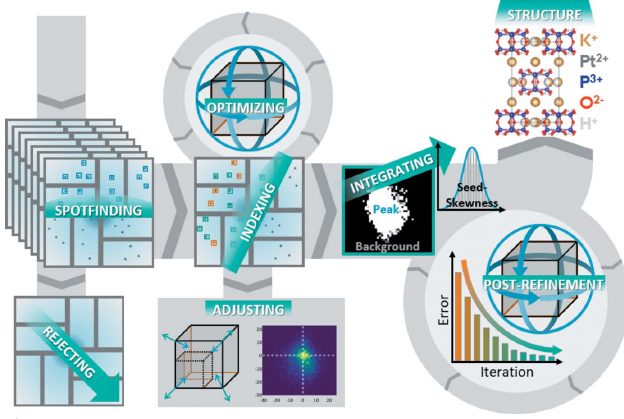
Figure 2 Schematic of the SFX data reduction pipeline including initial spot- finding, indexing using an optimized version of the SPIND algorithm, integration based on a seed-skewness method and a post-refinement process including various corrections. The final output is a list of merged structure